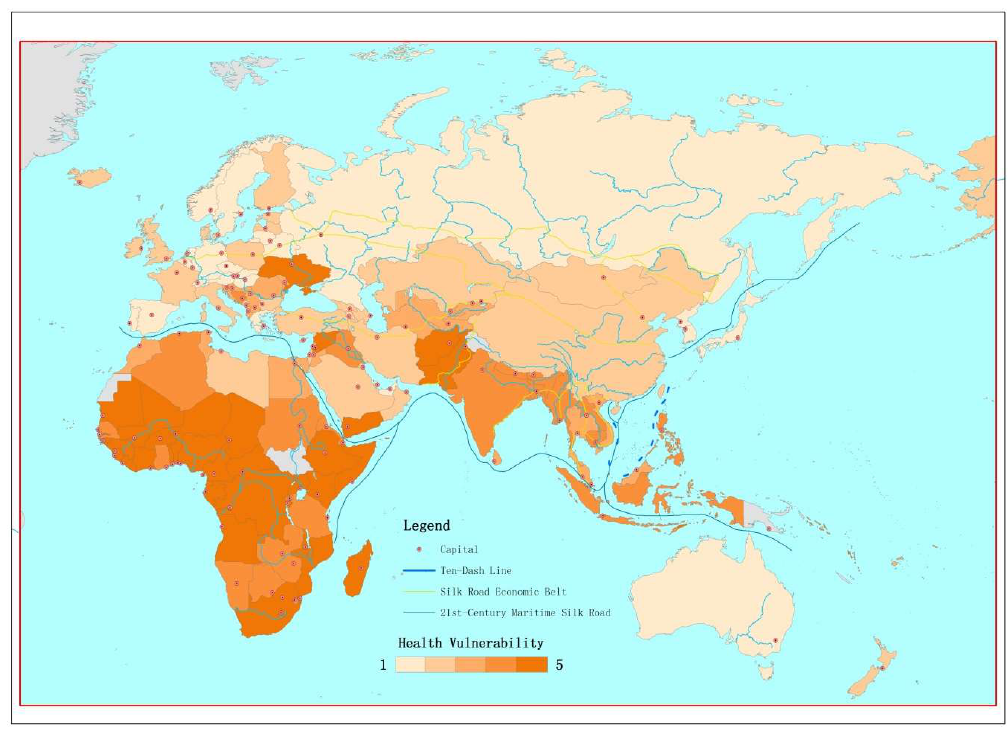
Figure 4. Health Vulnerability Index of countries along the Belt and Road Initiative (BRI) region. Note: deeper color indicates greater vulnerability.